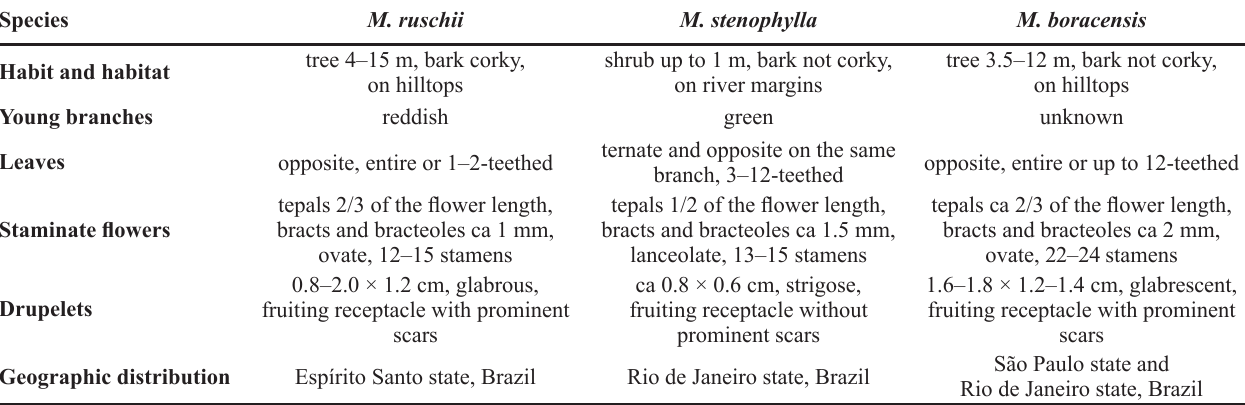
Table 1 – Comparison of Mollinedia ruschii with the morphologically similar species M. boracensis and M. stenophylla